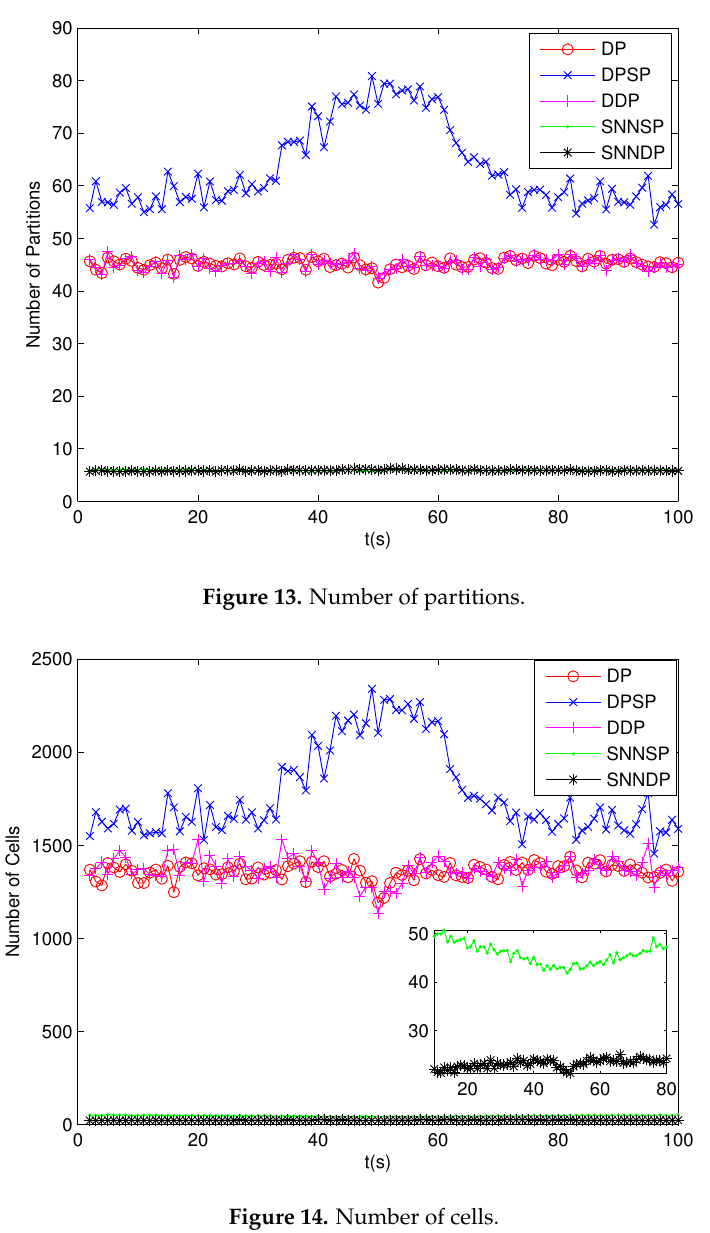
Figure 14. Number of